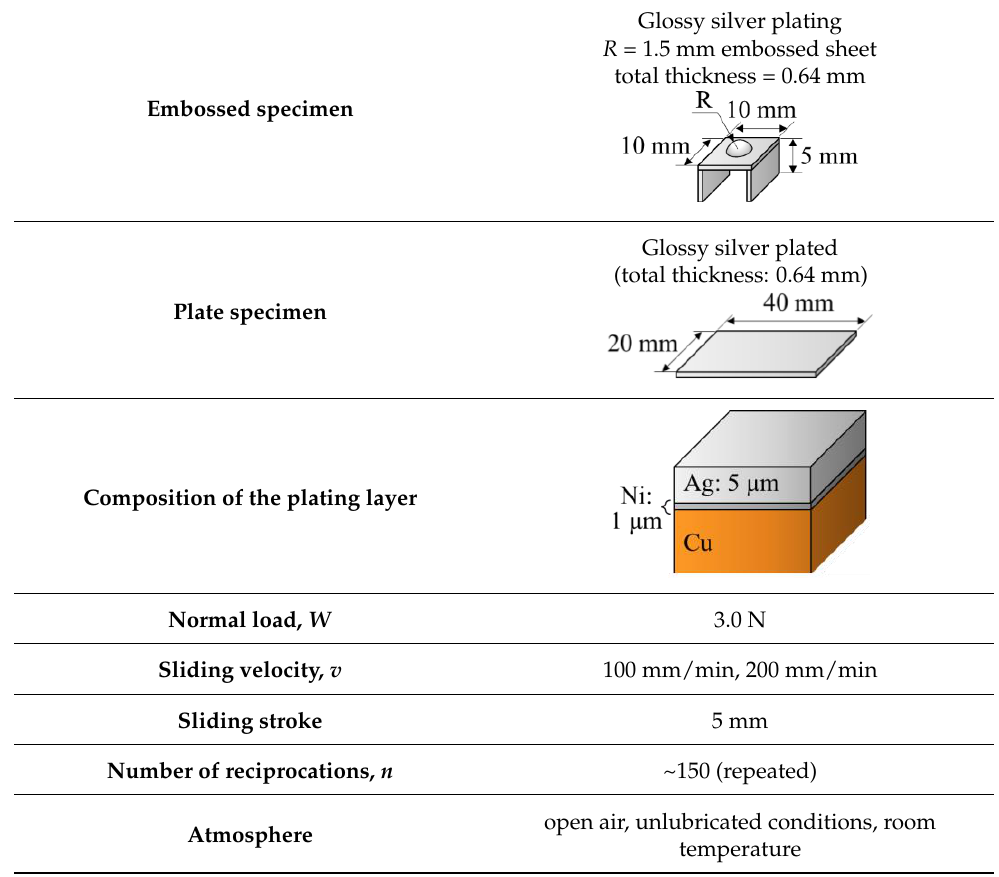
Table 2. Summary of the specimens and the sliding